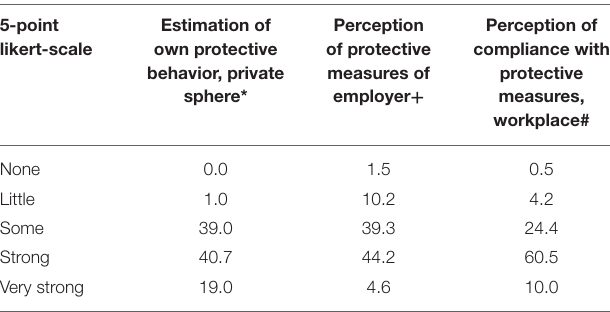
TABLE 4 | Individual protection behavior and workplace measures, perceptions, valid percentage of